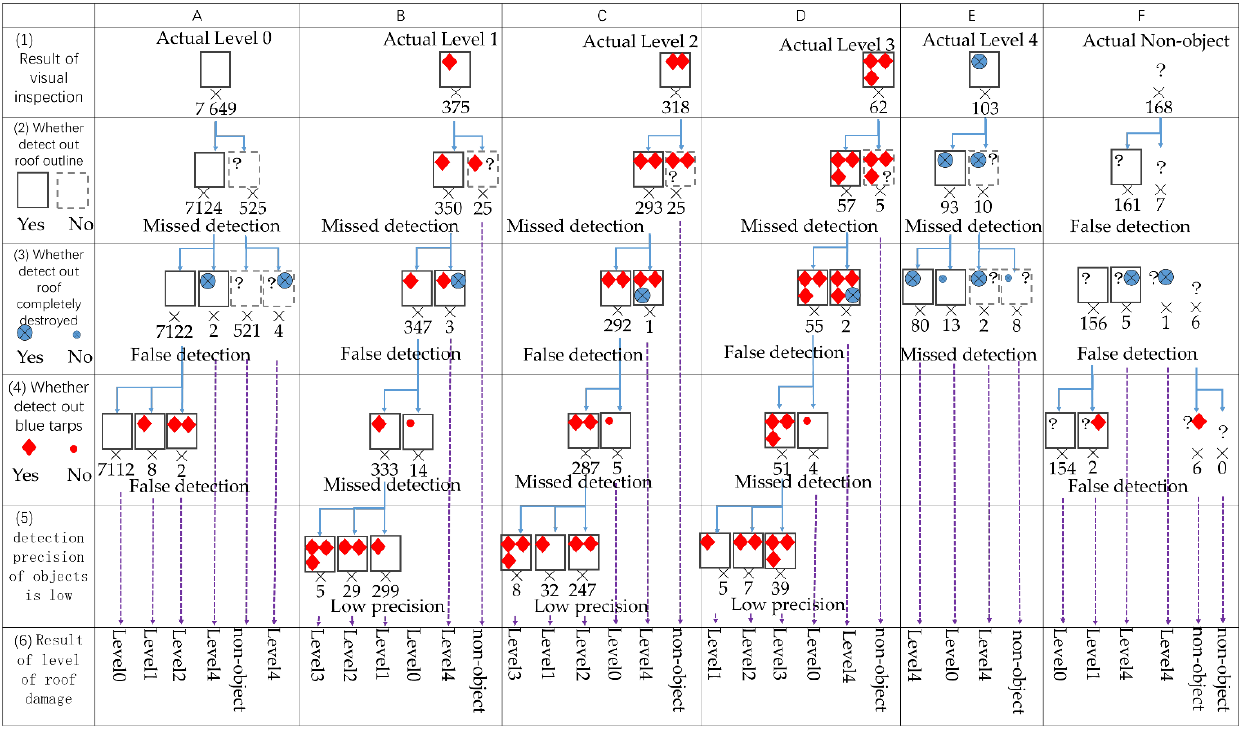
Figure 16. Results of the detection and classification for the green areas in Figure 3. ( a ) Aerial photo in Tateyama city. ( b ) Each detected object using deep learning. ( c ) the level of roof damage using automatically classification.